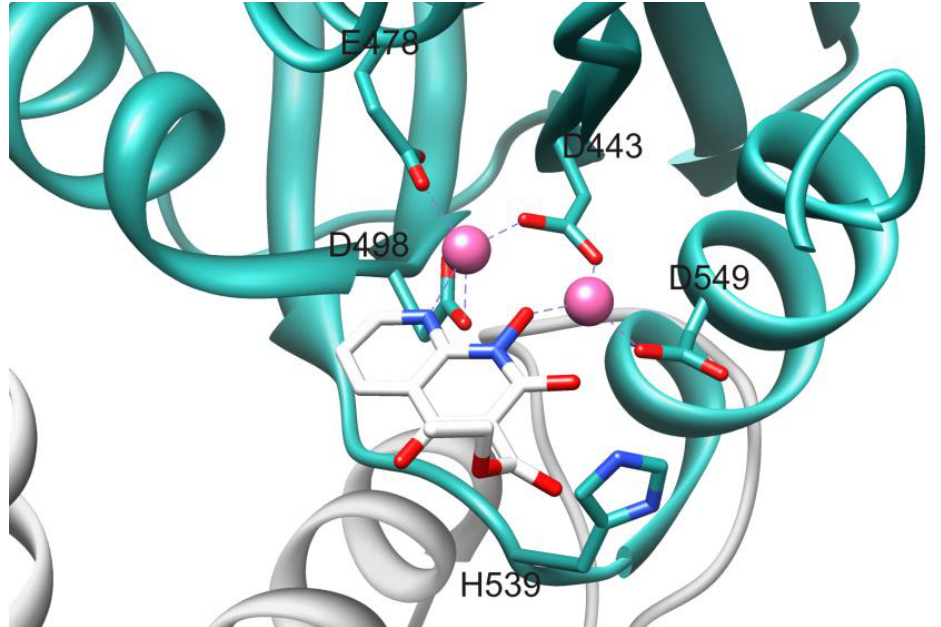
Figure 6. Binding of the N-hydroxy naphthyridinone inhibitor MK1 to the RT RNase H active site. The figure is derived from PDB file 3LP0 and was drawn using UCSF Chimera software [6]. Dashed lines indicate interactions with the metal